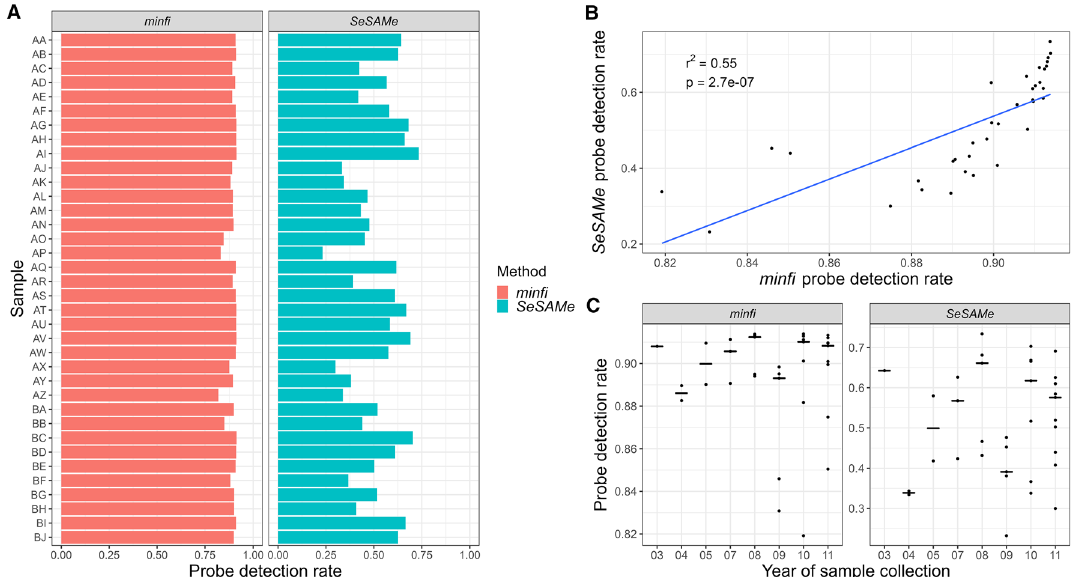
Figure 1. Probe detection rates (probe DR). ( A ) Probe DR of all samples analysed with minfi and SeSAMe , respectively. ( B ) Correlation between probe DRs analysed with minfi and SeSAMe . ( C ) Dot plot of probe DRs of samples collected in the years 2003–2011 and analysed with minfi (r 2 < 0.01; p > 0.05) and SeSAMe (r 2 = 0.01; p > 0.05), respectively, vertical bar indicates median